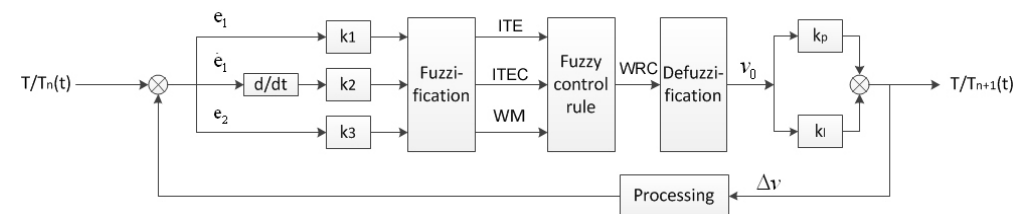
Figure 4. The fuzzy controlling